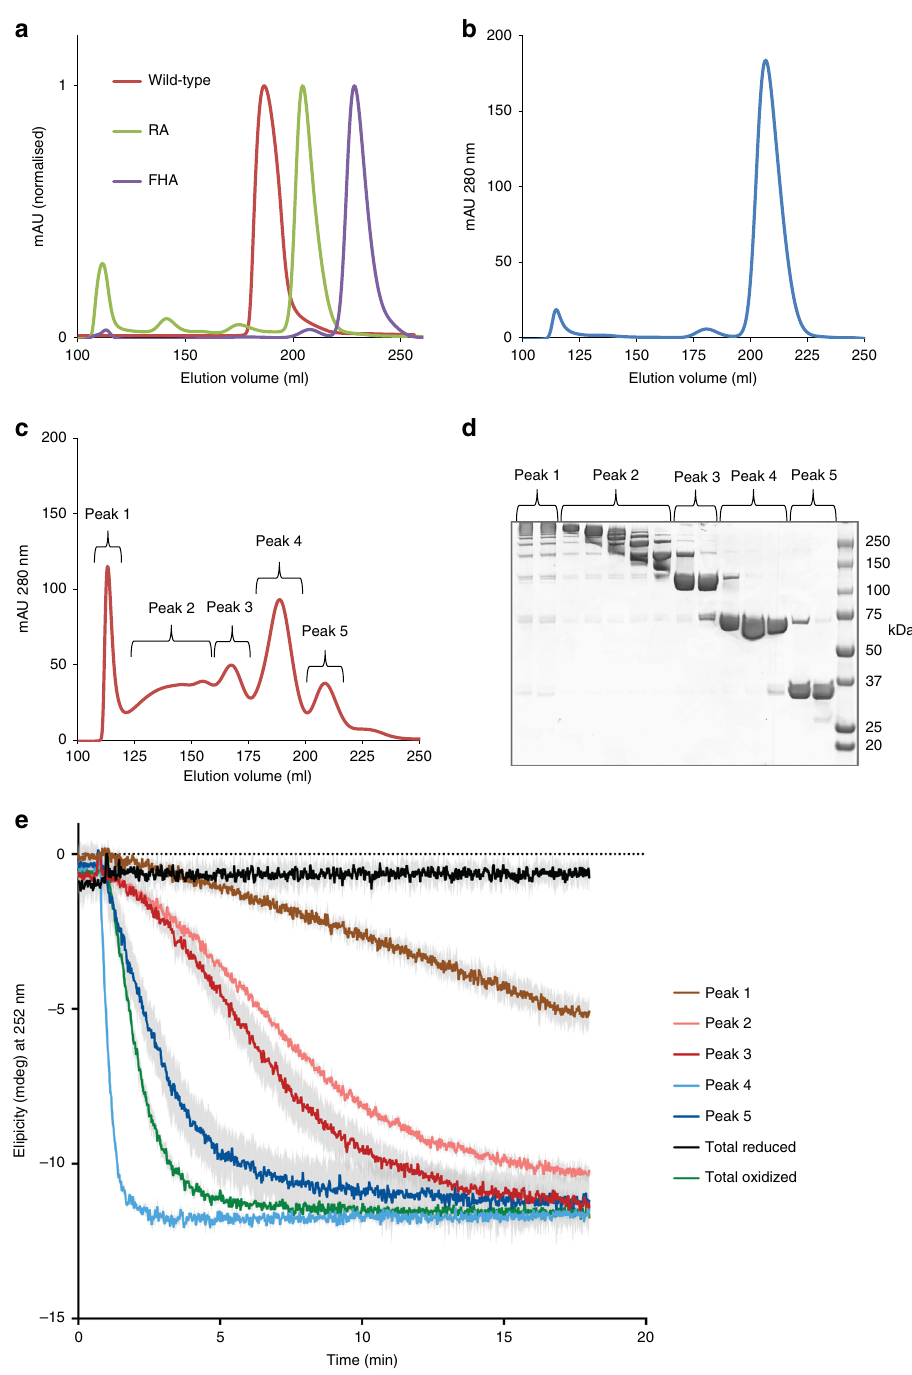
Fig. 5 The effects of DgcB oligomerization state on diguanylate cyclase activity. a Puri fi ed DgcB wild-type, R218A mutant and FHA domain proteins were analysed by gel- fi ltration and hypothetical molecular weights were estimated by comparison with the elution pro fi les of proteins of known molecular weights. b Gel- fi ltration pro fi le of DgcB S15C-S73C-R218A mutant protein under reducing conditions and c under non-reducing conditions following incubation with oxidised glutathione to drive disul fi de bond formation. Elution fractions collected during this experiment were assigned to fi ve